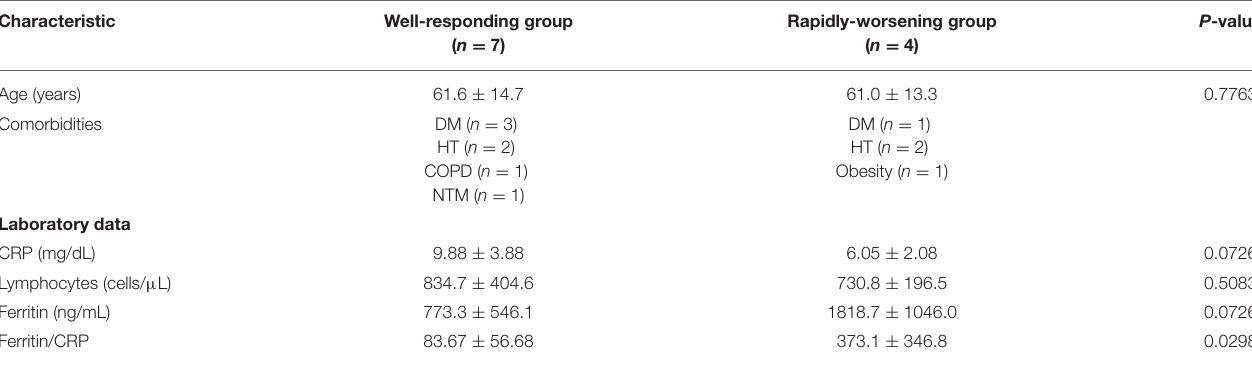
TABLE 2 | Comparative characteristics before tocilizumab administration between the well-responding group and rapidly-worsening group.